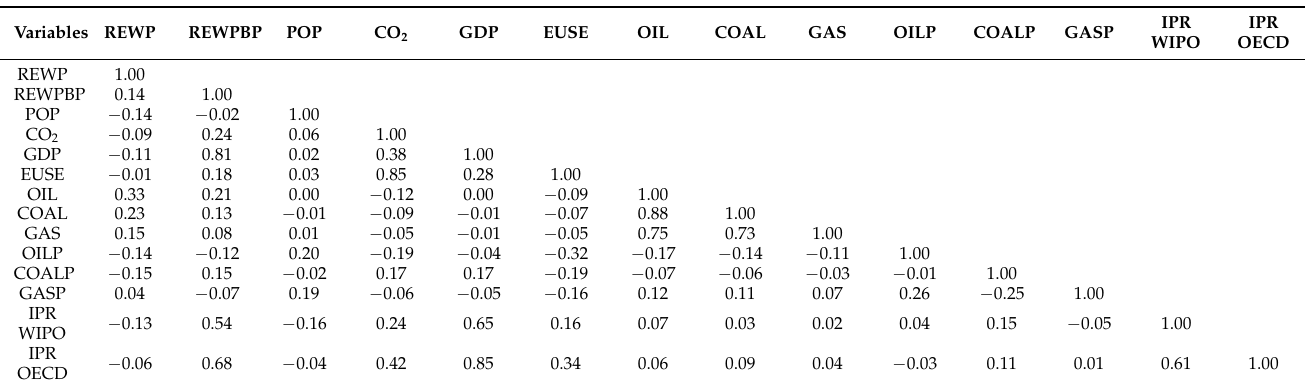
Table A3. Correlation